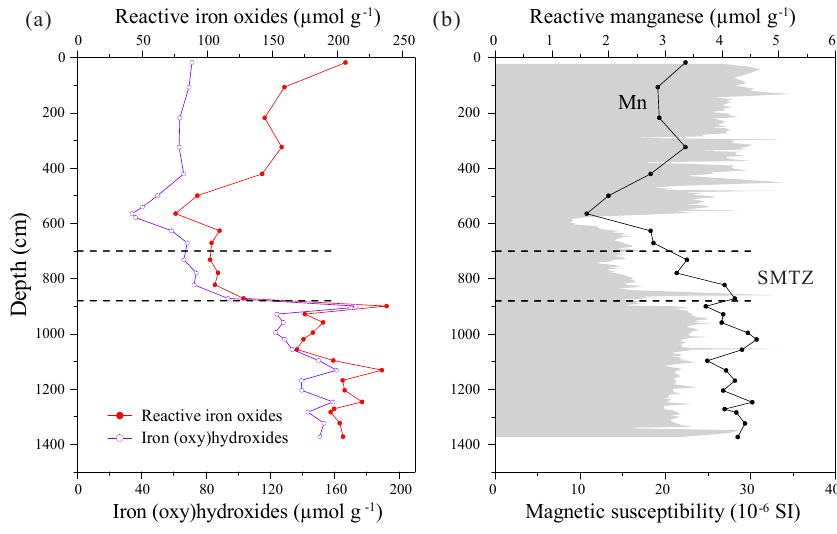
Figure 8. Depth distribution profiles of (a) Fe (oxy)hydroxides and reactive Fe-oxides, (b) reactive manganese and magnetic susceptibility. Magnetic susceptibility data are adopted from R. Lin et al.